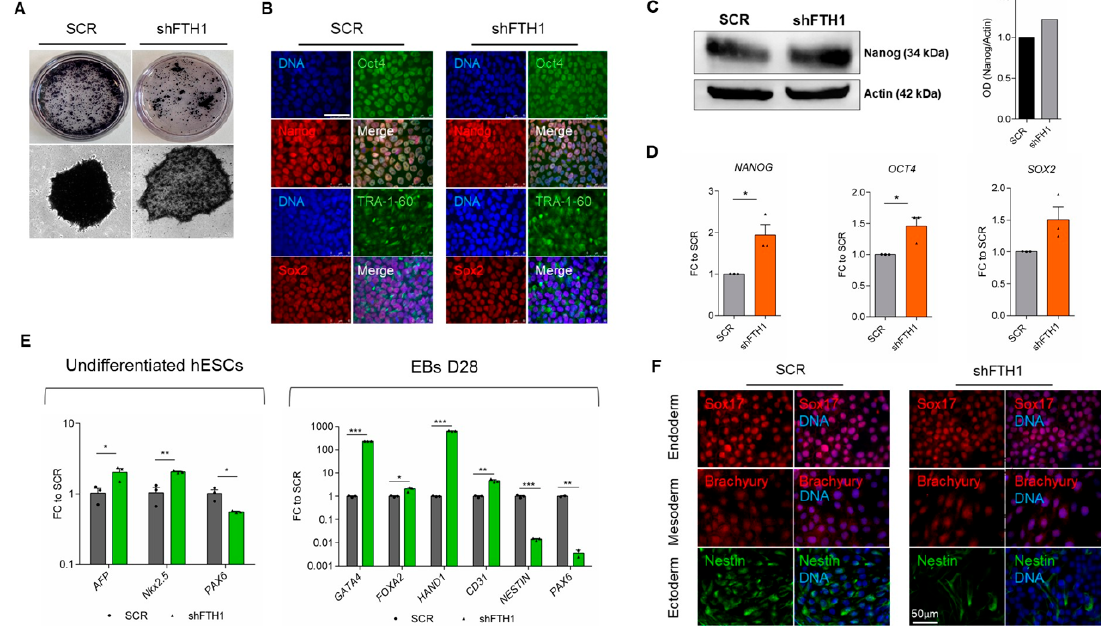
Figure 1. FTH1 silencing influences hESCs pluripotency. ( A ) Alkaline phosphatase (AP) staining of colonies in SCR control and in hESCs transfected with lentiviral shFTH1 shows that FTH1-silenced ES colonies contain less AP+ cells; scale bar, 250 µ m; ( B ) Undifferentiated SCR and FTH1-KD hESCs were stained for Oct4 (green), Nanog (red), TRA-1-60 (green), and Sox2 (red) expression, while nuclei were counterstained with 4 (cid:48) .6-diamidino-2-phenylindole (DAPI). Scale bars, 50 µ m. No significant differences were detected between the two groups with the exception of Nanog, which shows a slight positivity in FTH1-silenced cells; ( C ) The levels of Nanog protein were assessed by immunoblotting (IB). Band intensity analysis shows a higher level in FTH1-KD cells compared to SCR control. Actin levels were evaluated to confirm equal loading